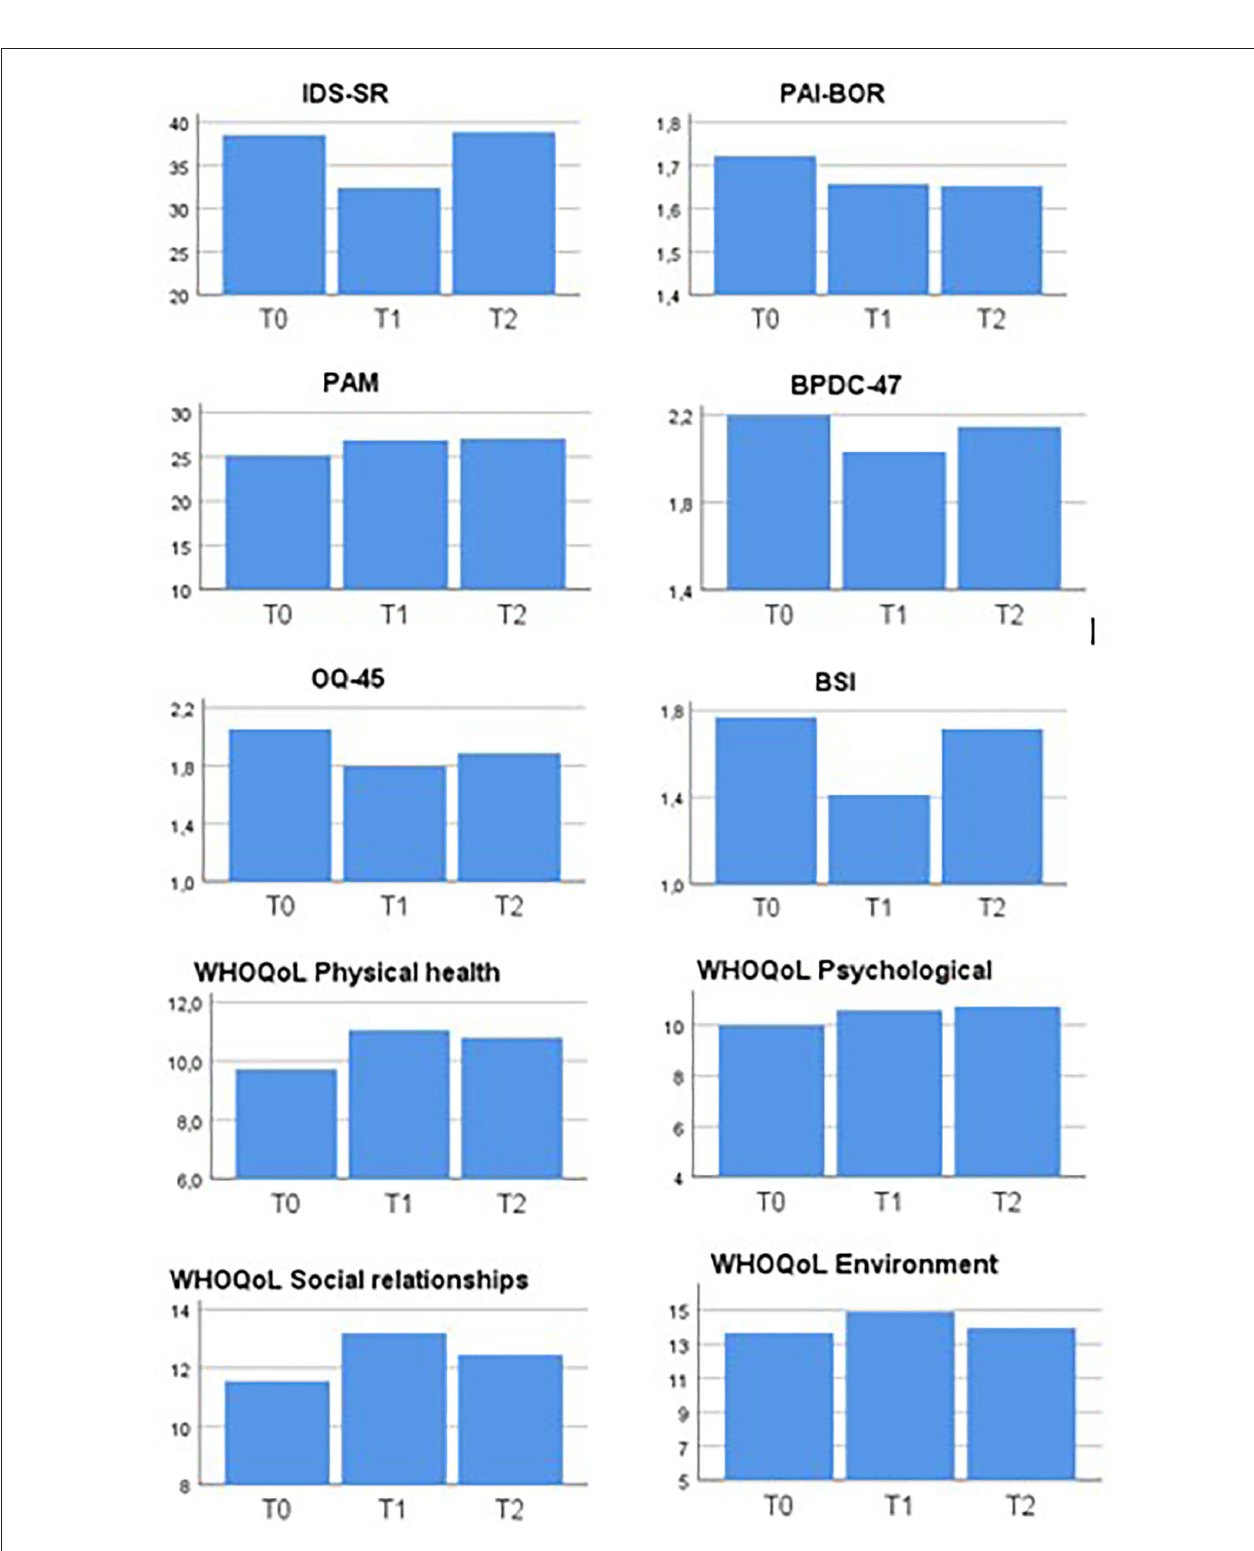
FIGURE 1 | Scores of self-rated outcome questionnaires at baseline (T0), post treatment (T1), and 6-month follow-up (T2) in nine outpatients with bipolar disorder treated with STEPPS. IDS-SR, Inventory of Depressive Symptoms—Self Rated; PAI-BOR, Personality Assessment Inventory—Borderline Features; BPDC-47, Borderline Personality Disorder Checklist; PAM, Patient Activation Measure; BSI, Brief Symptom Inventory; OQ-45, Outcome Questionnaire; WHOQoL, World Health Organization Quality of Life short version.